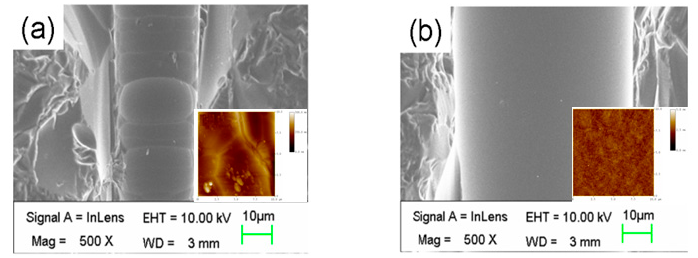
Figure 5. Scanning electron microscopic (SEM) images of the inner surfaces ( a ) before and ( b ) after drawing; Inset in (a,b): scanning probe micrographs of the etched inner surfaces before and after the